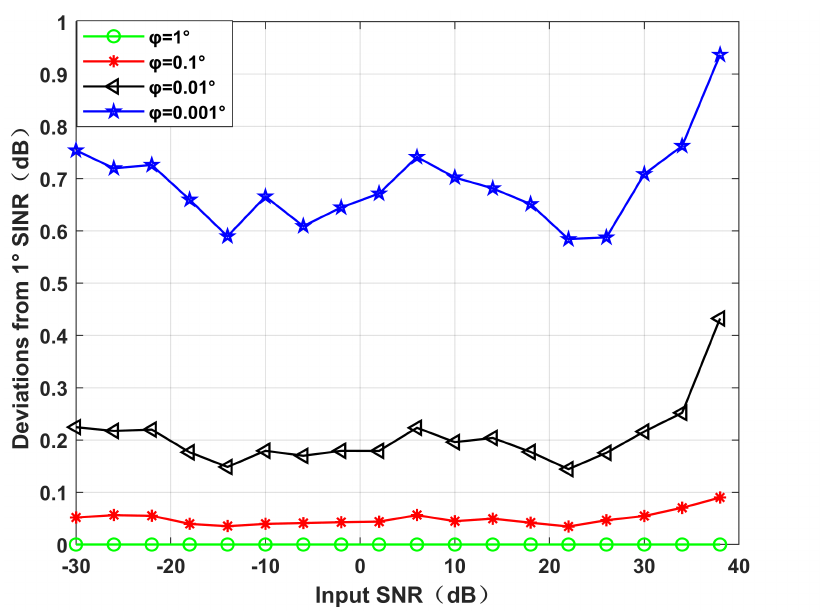
Figure 6. Decrease between each SINR and 1 ◦ virtual interference interval. Simulation 2. Simulation 3. Different null broadening range